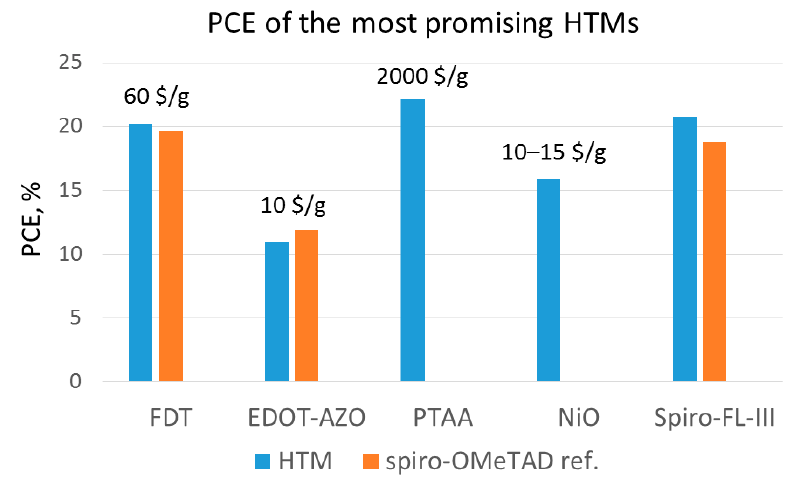
Figure 26. Summary of the most efficient HTMs discussed in this work, together with their cost (when available).